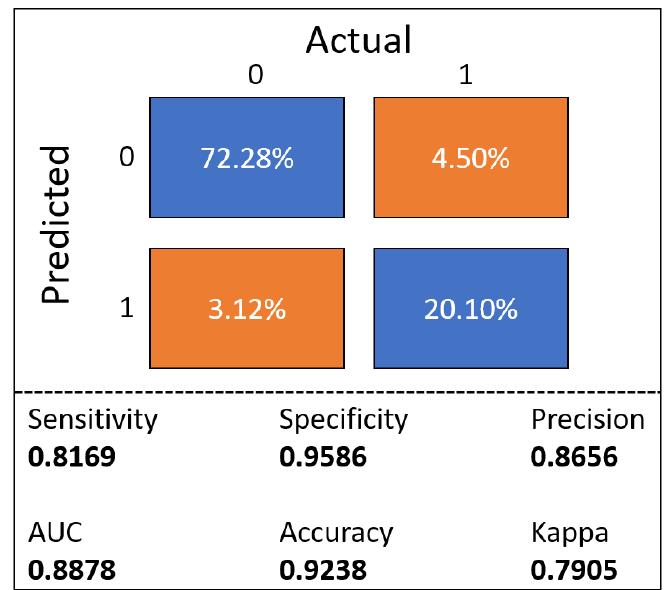
Figure 9. CNN Confusion matrix for the test dataset.